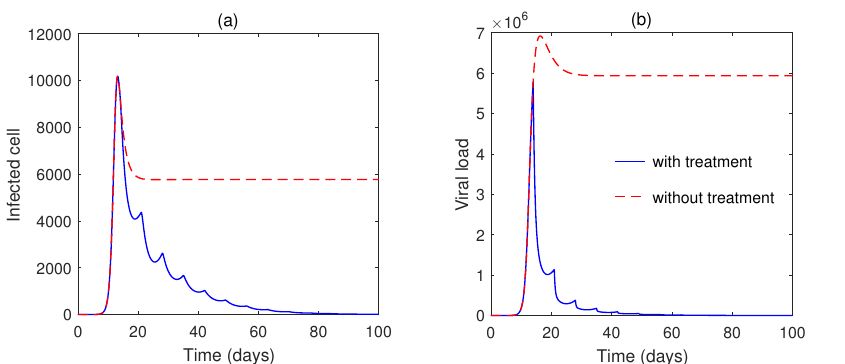
Figure 7. ( a , b ) Numerical solutions of impulsive Model 4 with treatment ( ω = 60, τ = 7) and without treatment.